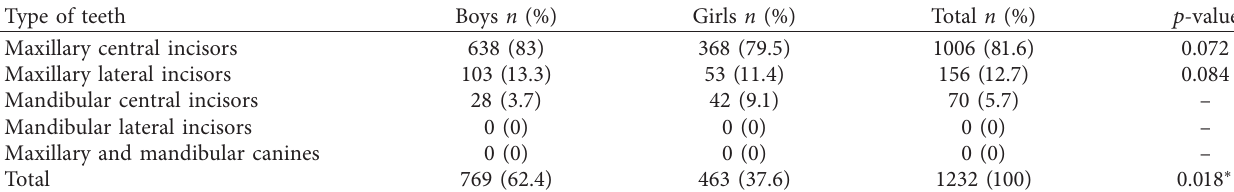
Table 4: Type of teeth involved in traumatic dental injuries according to